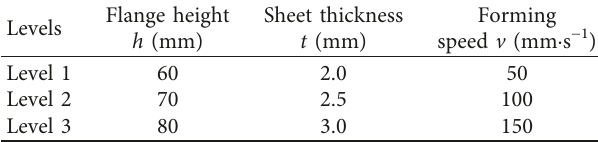
Table 1: Orthogonal experimental table of 3 factors and 3 levels.